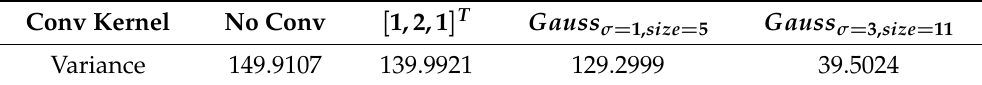
Table 1. Influence of different Z-direction convolution strategies on the variance of gradient direction